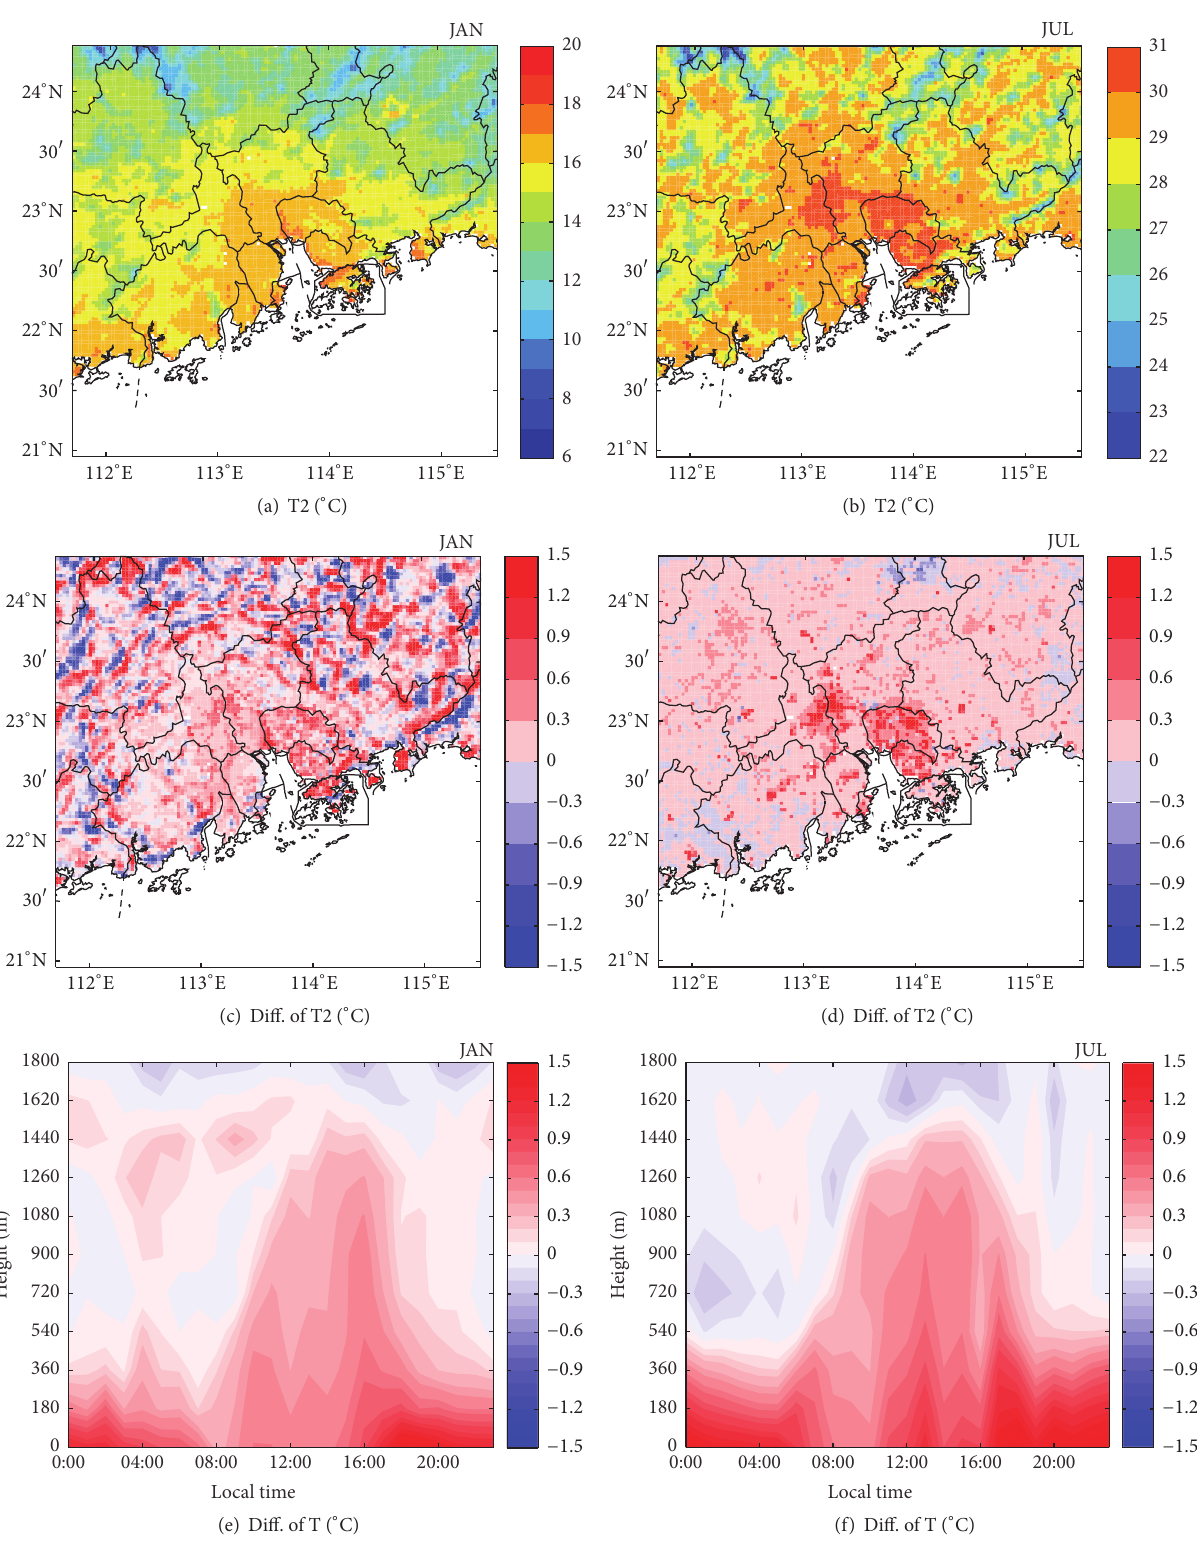
Figure 3: The simulated spatial distribution of monthly-average 2 m temperature ( ∘ C) in the GLC2009 case (a, b), spatial distribution (c, d), and vertical distribution over GZ (e, f) of monthly-average temperature differences ( ∘ C) (differences = GLC2009 −